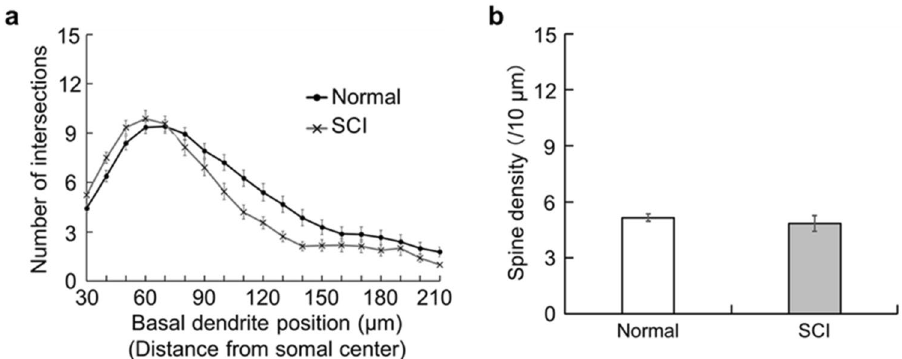
Figure 8. Morphology of basal dendrites of large layer V pyramidal neurons in M1 face region. ( a ) Histogram showing the intersection number of basal dendrites at every 10-µm position in a normal control (Normal) and an SCI model (SCI). Two-way ANOVA. ( b ) Histogram showing the spine density of basal dendrites in a normal control (in white) and an SCI model (in gray). Student